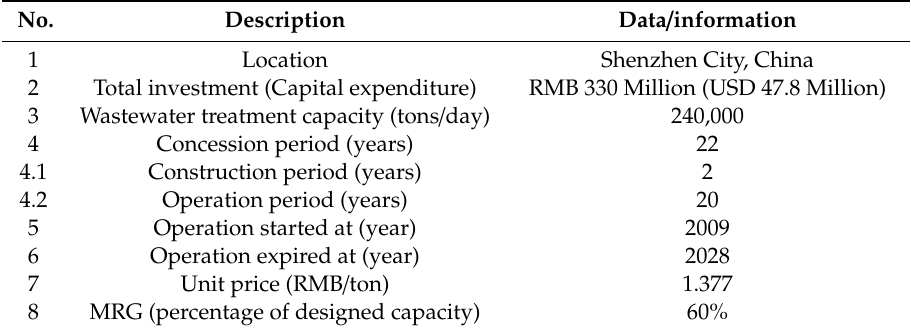
Table 3. Detailed information of the Shenzhen Gushu Wastewater Treatment Plant (Phase I).